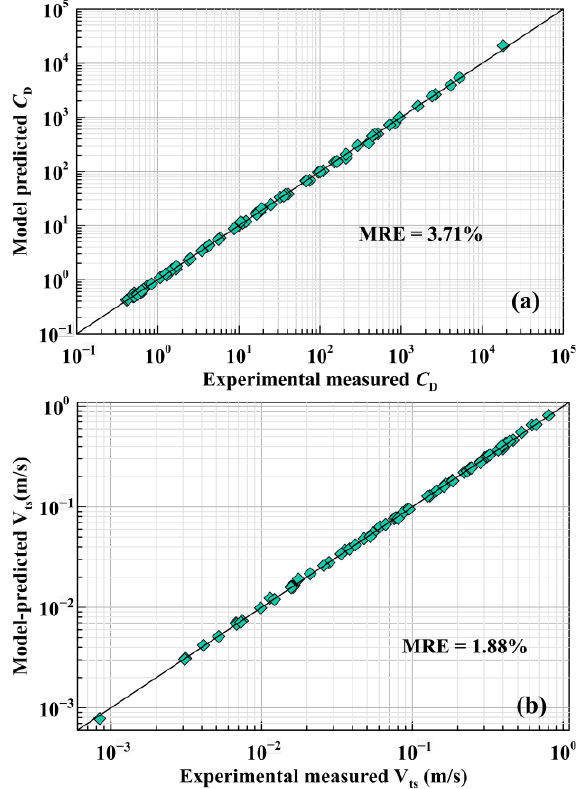
Figure 10. Comparison between the experimentally measured and model-predicted results for a sphere settling in Newtonian fluid: ( a ) drag coefficient; ( b ) settling velocity. sphere settling in Newtonian fluid: ( a ) drag coefficient; ( b ) settling